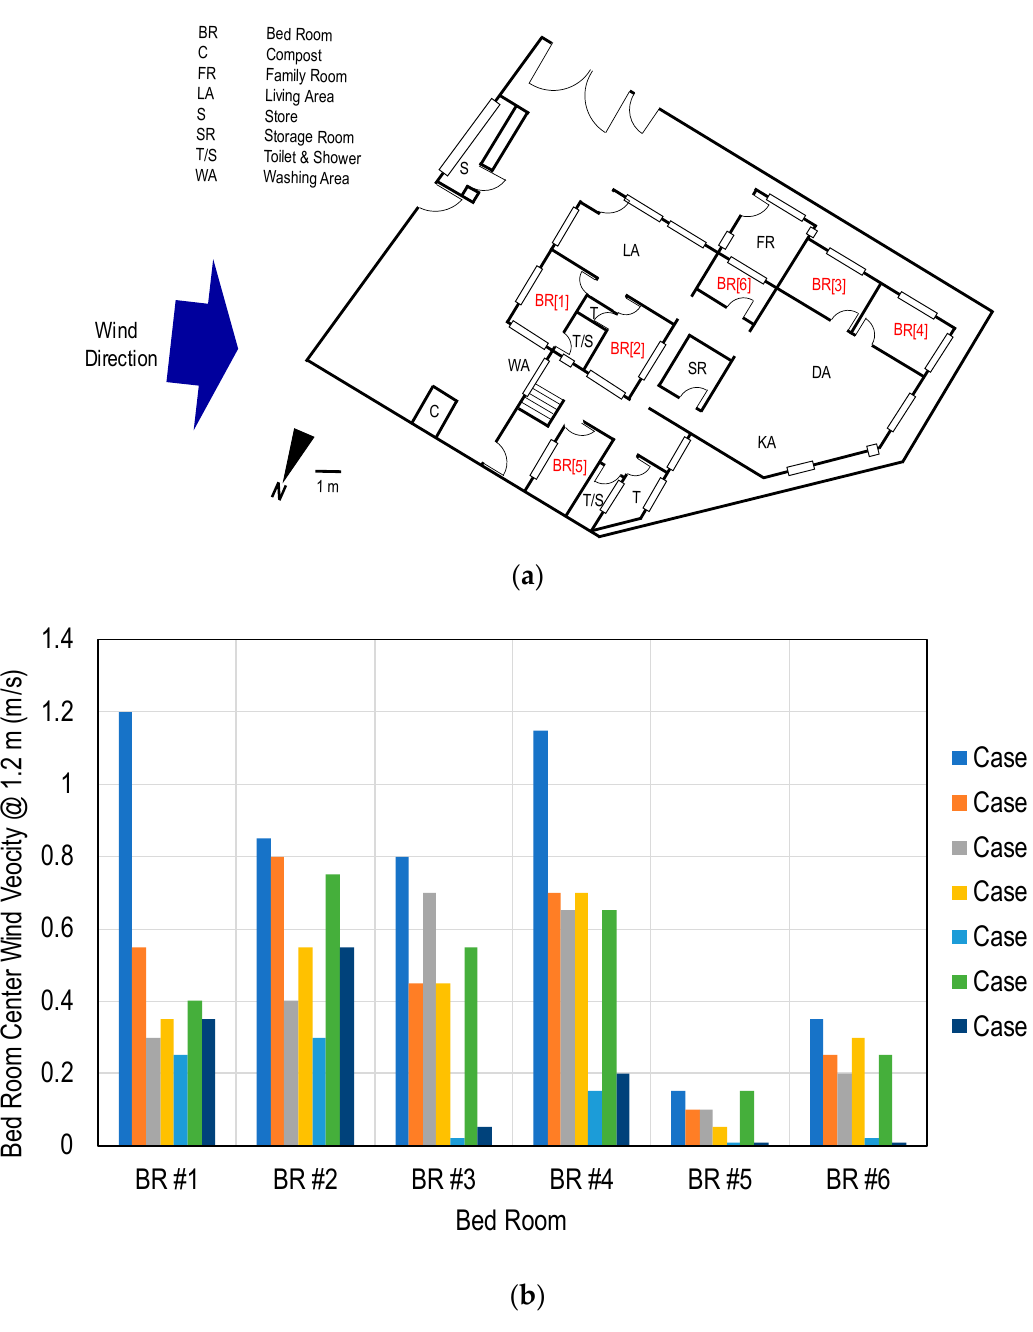
Figure 13. Wind speed at the center of the different bedrooms (BR) at the height of 1.2 m for the different Figure 13: Wind velocity at the center of the different bedrooms (BR) at the height of 1.2 m for the 469 cases of house renovation, combining door and window openings and taking into consideration the left different cases of house renovation, combining door and window openings and taking 470 wall opening (see Table 1 for more information of the different cases): ( a ) Floor plan, and ( b ) Wind into consideration the left wall opening (See Table 1 for more information of the 471 different cases). 472